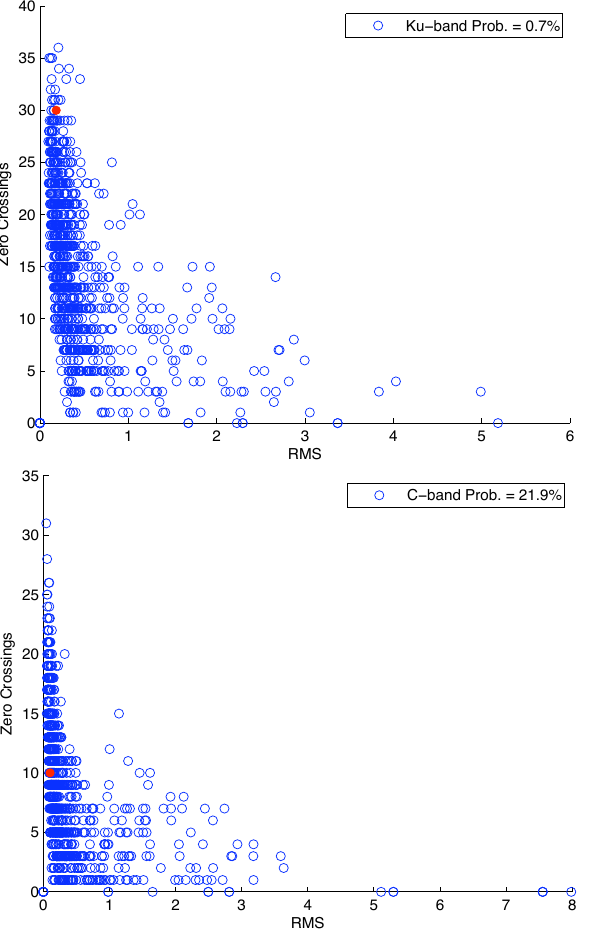
Fig. 9. Results from the statistical randomization tests on the radar backscattering strength for pass 143 of Jason-1 cycle 300. Statisti- cal significance of the hypothesis that surface roughness variations with and without the tsunami are not substantially different is found to be 0.7% and 21.9% for the Ku-band and C-band measurements